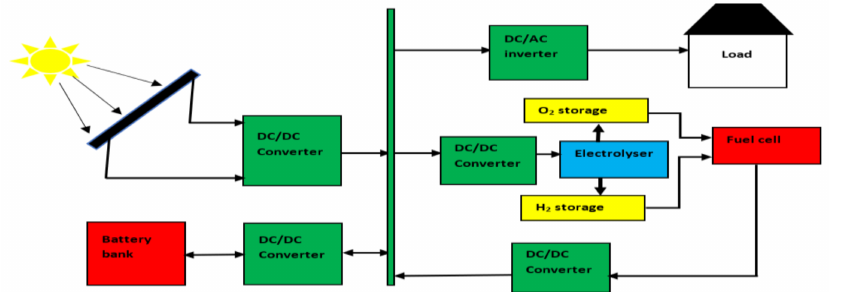
Figure 1. Schematic diagram of an IPVFC system including a PV, battery, electrolyser, and fuel